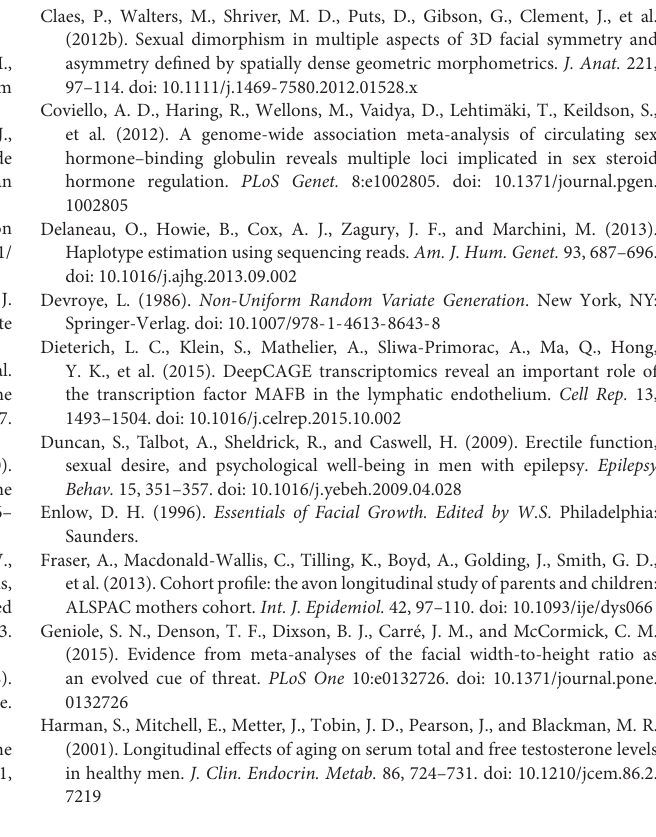
FIGURE S1 | Five facial ratios tested for association with the candidate SNPs. (A) Total facial width to height ratio (Total FWH). (B) Upper facial width to height ratio – version 1 (Upper FWH1). (C) Upper facial width to height ratio – version 2 (Upper FWH2). (D) Lower facial width to height ratio (Lower FWH). (E) Upper to lower facial width ratio (Upper:Lower FW). FIGURE S2 | Results of the meta-analysis in the post-pubertal subset. Representation of the significant modules of the meta-analysis based on the different discovery datasets. TABLE S1 | List of 44 candidate SNPs selected from the